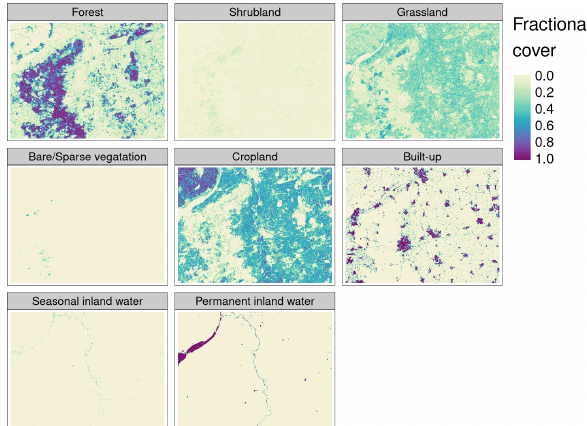
Figure 1. Fractional cover (0-1) of the 8 base land cover classes in the eastern